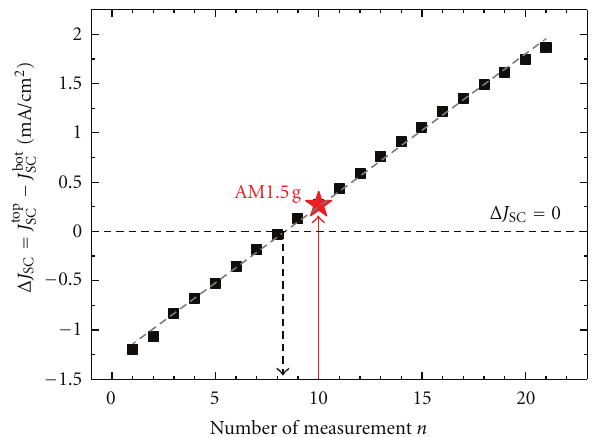
top bot rises lin- SC SC SC of the measurement as postulated Δ𝐽𝐽𝐽𝐽 𝑁𝑁 𝐽𝐽𝐽𝐽 − 𝐽𝐽𝐽𝐽 , 𝑛𝑛𝑛𝑛 mA/cm , SC . 𝑛𝑛𝑛𝑛 𝑁𝑁 𝑁𝑁0 𝑁𝑁 𝑁𝑁 0 Δ𝐽𝐽𝐽𝐽 𝑛𝑛𝑛𝑛 𝑁𝑁 𝑛𝑛